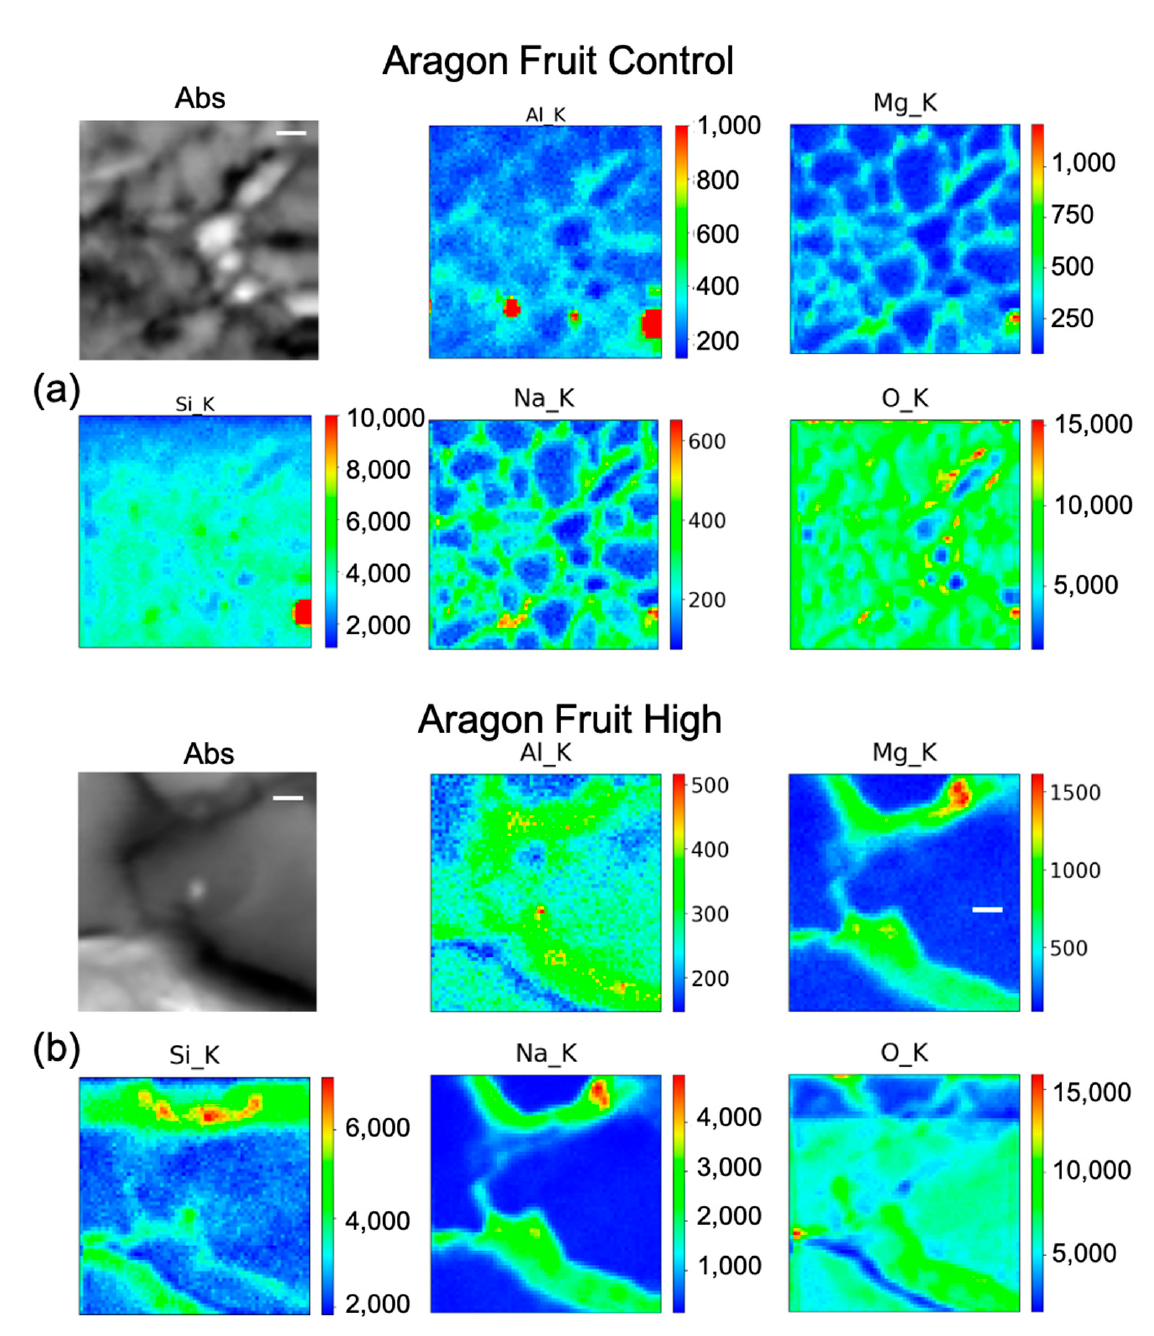
Figure 6. Micro-X-ray Fluorescence ( µ -XRF) elemental maps of O, Al, Na, Mg, and Si, depicting the distribution within the cells of ( a ) Aragon Fruit Control, and of ( b ) Aragon Fruit High Si treatment, shown with their corresponding absorption image (Abs). Scale bar is 10 µm.